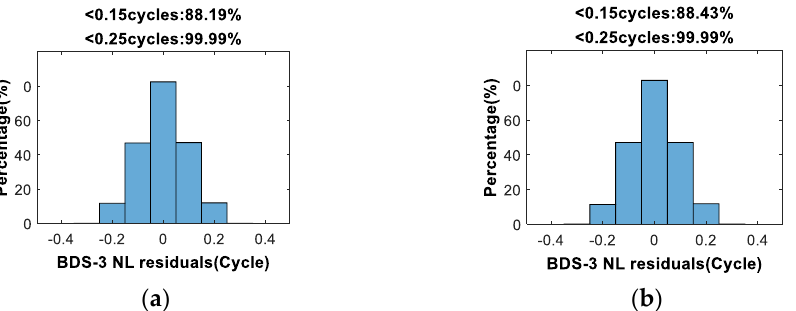
Figure 8. Distribution of float posteriori NL ambiguity residual errors (2021, day 185) as ( a ) posteriori residual errors when estimating NL FCB with traditional method; ( b ) posteriori residual errors when estimating NL FCB with proposed method.